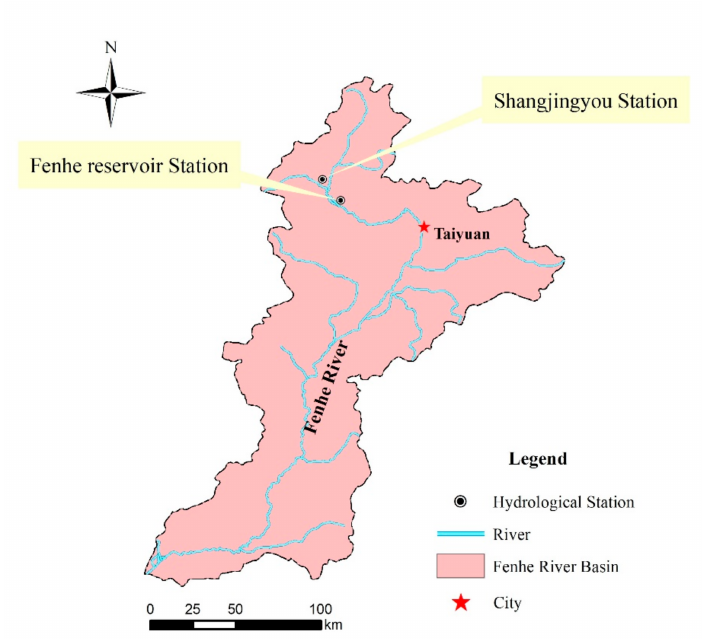
Figure 6. The study area and location of the two hydrological stations.